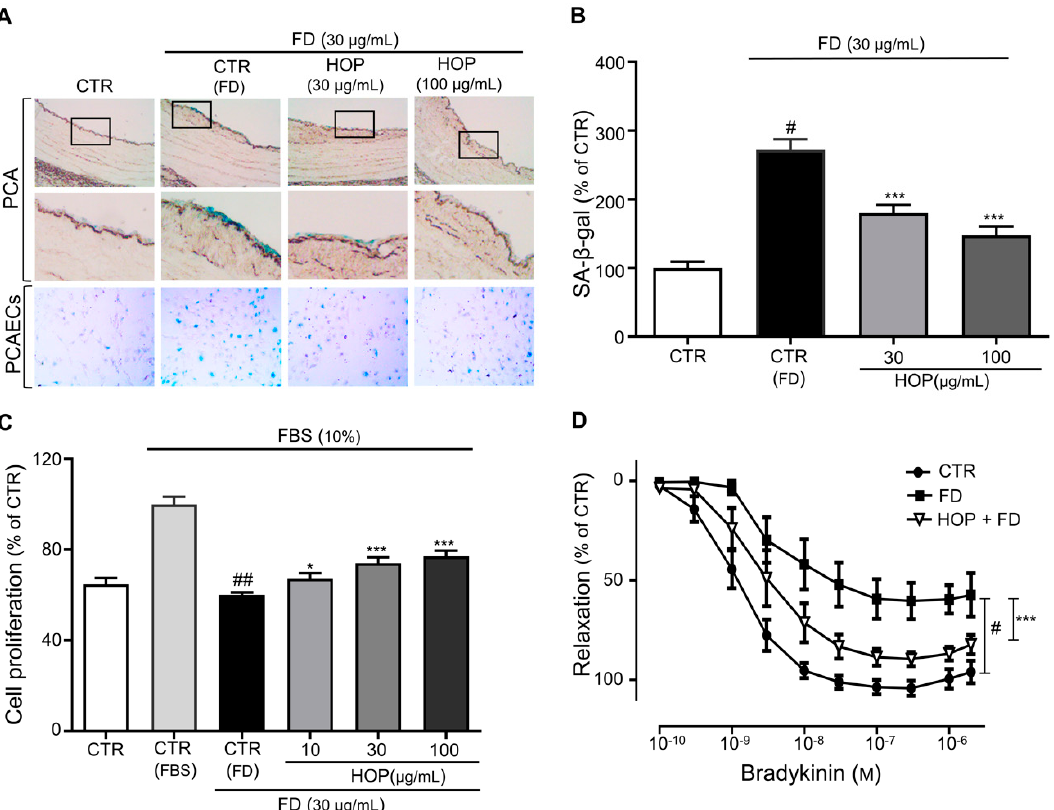
Figure 1. Hop extract (HOP) prevents fine dust (FD)-induced premature senescence. ( A ) Porcine coronary artery (PCA) rings and PCA endothelial cells (PCAECs) were incubated in the presence of FD or FD with either 30 or 100 µ g / mL HOP before determination of senescence-associated β -galactosidase (SA- β -gal) activity by X gal staining. Representative images of SA- β -gal staining of PCA rings and PCAECs. ( B ) Cumulative data of SA- β -gal activity as a percentage of control. Data are expressed as the mean ± standard error of the mean (SEM) ( n = 5); # p < 0.05 vs. control (CTR); *** p < 0.001 vs. FD alone (CTR-FD). ( C ) Dose-dependent increases in cell proliferation upon FD with HOP (10, 30, or 100 µ g / mL) treatment. Data are expressed as the mean ± SEM ( n = 6); ## p < 0.01 vs. fetal bovine serum (FBS) alone (CTR-FBS); * p < 0.05, *** p < 0.001 vs. FD alone (CTR-FD). ( D )